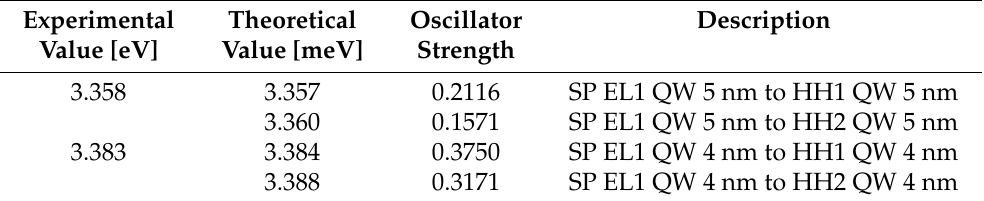
Table 3. Single particle (SP) energy transitions, oscillator strength both calculated in 8 k·p model and corresponding experimental values for structure #2: 2 QWs with widths 5 and 4 nm and 2.5 nm barrier between